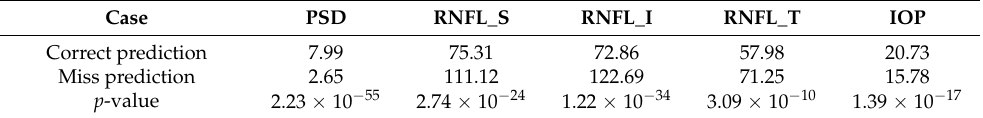
Table 8. Analysis of prediction: glaucoma cases.